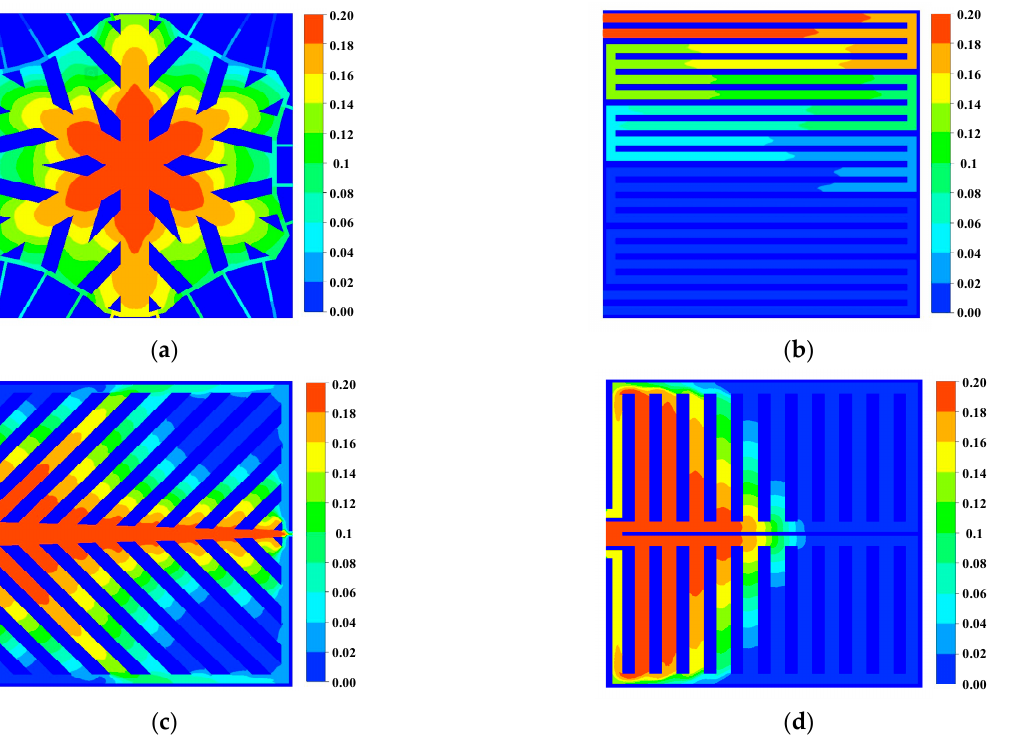
Figure 5. Oxygen mass fraction in the flow channel (0.8 V): ( a ) Snowflake bionic flow channel; ( b ) dual serpentine flow channel; ( c ) leaf-shape bionic flow channel; ( d ) lung-shape bionic flow channel.